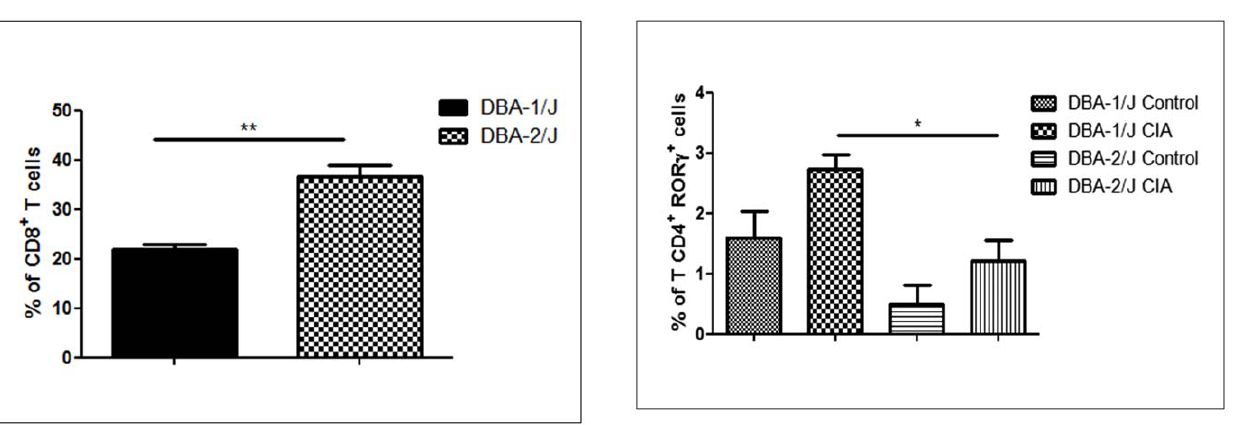
Figure 8. Post-transcriptional miRNA-mRNA interaction net- works based on microarray expression data from peripheral CD3 + T cells during collagen induced arthritis (CIA). The networks were obtained using the GenMir ++ algorithm. This figure shows the participation of A) six miRNAs up-regulated in peripheral CD3 + T cells of DBA-1/J mice and B) eleven miRNAs up-regulated in peripheral CD3 + T cells of DBA-2/J mice. These miRNAs interact with mRNAs related to immune system. The control mice were immunized just with complete Freund’s adjuvant without any collagen.